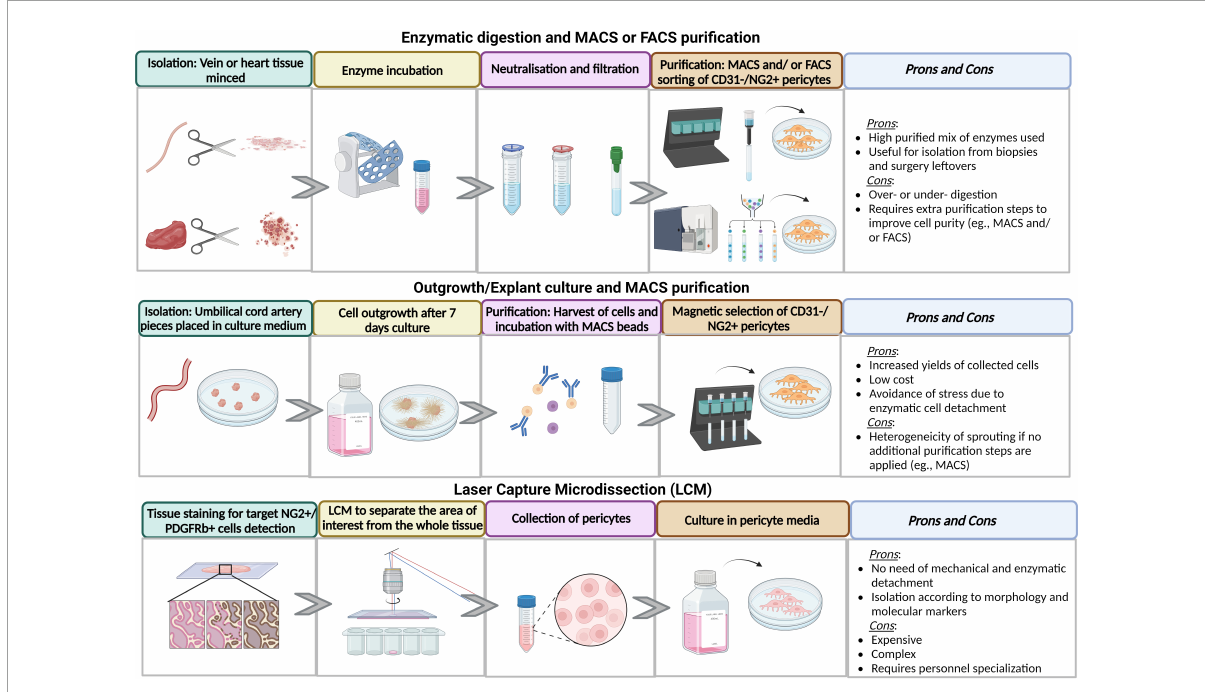
FIGURE2 Advantages and disadvantages of different methods of isolation and purification methods. Figure created in Biorender.com